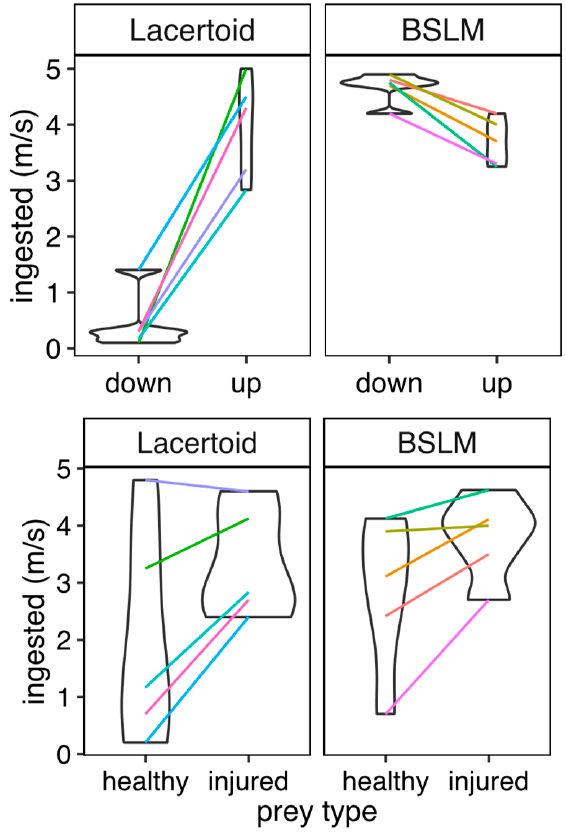
Figure 4. ( Upper row ). Comparison of predatory performance between 5 BSLM and 5 lacertoid species eating uninjured and leg injured crickets during a 24 h experiment. ( Lower row ). Results of an analogous experiment (134 observations) on the same species but comparing lizards’ capability of hunting on surface prey vs. prey located under sand (termites). Colored lines connect the mean values of the same species in each treatment.